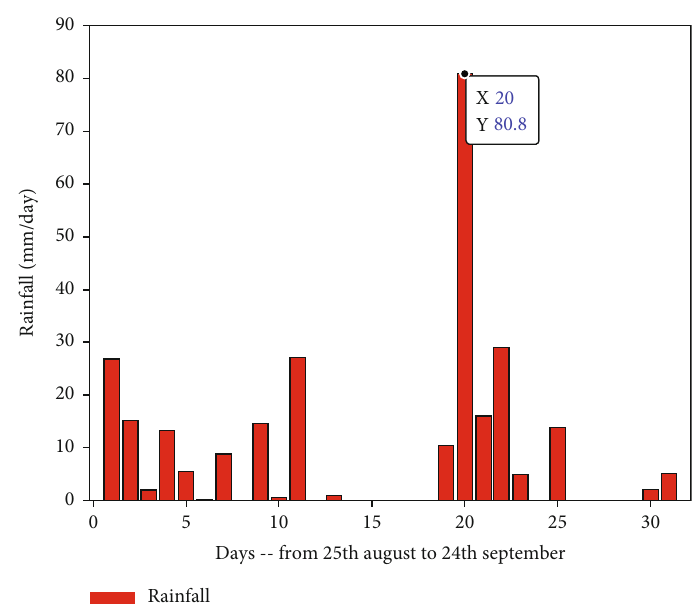
Figure 23: Rainfall monitoring results.